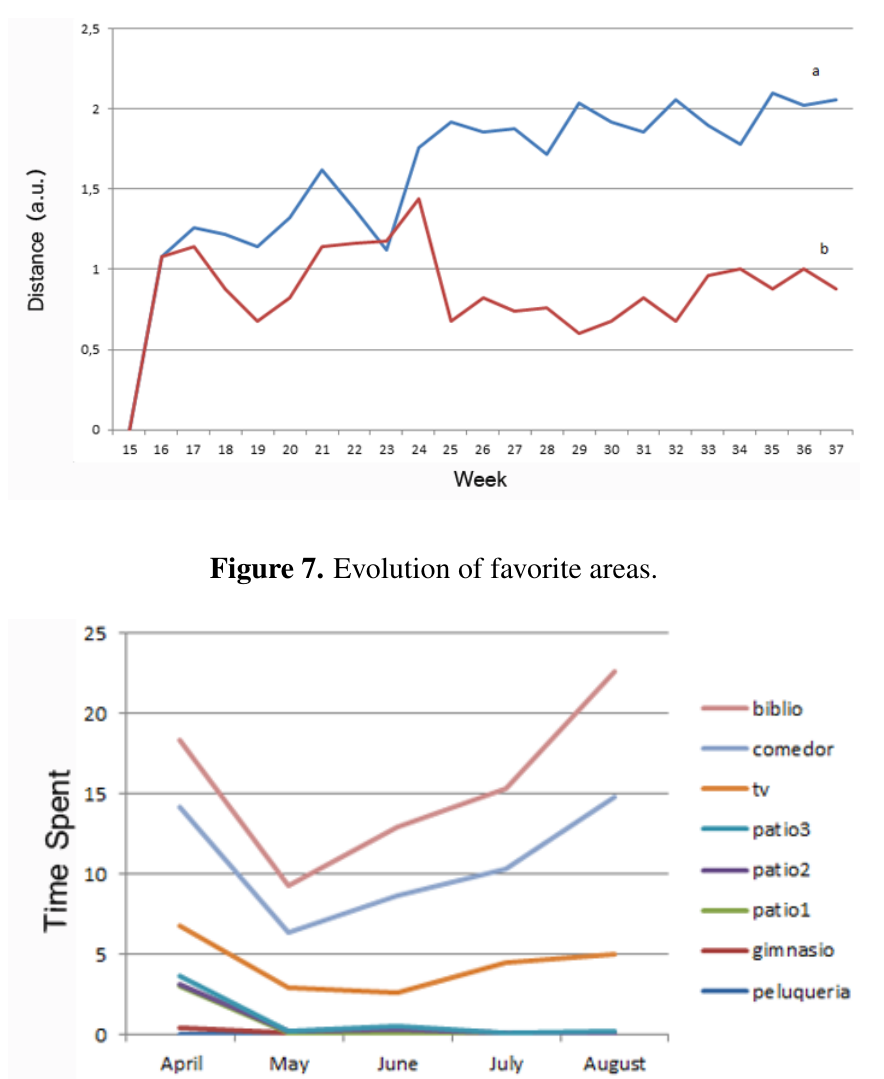
Figure 6. Evolution of workflow distances: ( a ) Absolute workflow distance; ( b ) Partial workflow distance (velocity).